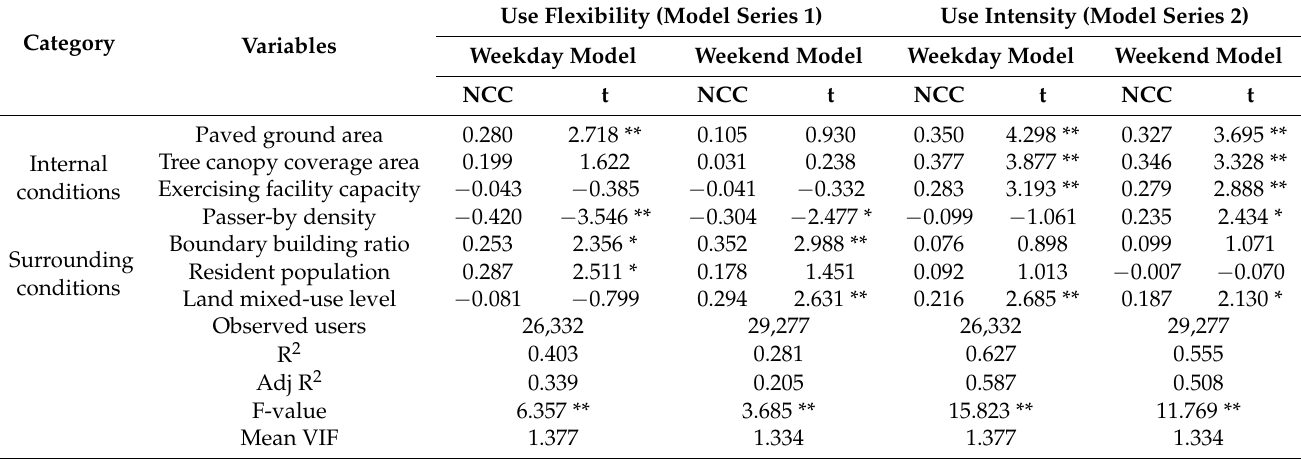
Table 4. Results from regression model series ( n =